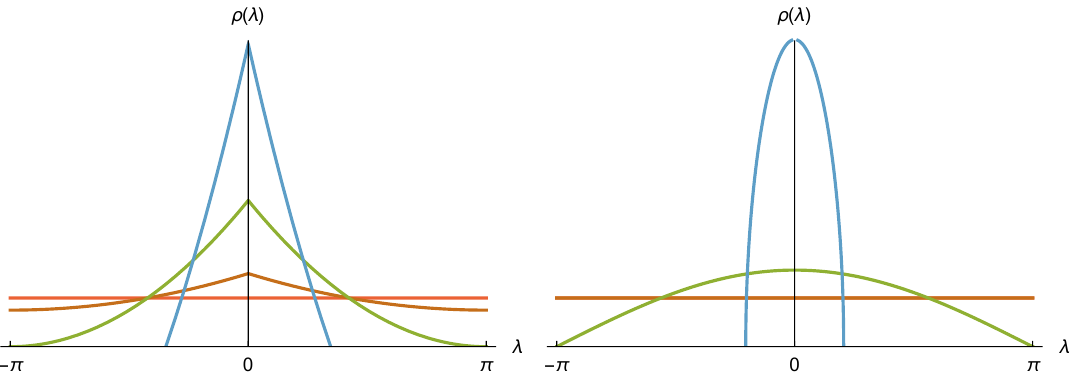
Figure 1 . Left: eigenvalue distribution in vector model at d = 3 for T=T c (cid:28) 1 (red), T=T c = 1 = 2 (orange), T=T c = 1 (green) and T=T c (cid:25) 2 (blue). Right: eigenvalue distribution in adjoint model at d = 4 for T=T c (cid:28) 1 (red), T=T c = 1 = 2 (orange), T=T c = 1 (green) and T=T c (cid:25) 2 (blue). In this case, curve remains the same for all T (cid:20) T c and the phase transition is (cid:12)rst order. For T=T c ! 1 , the distribution approaches a (cid:14) -function in both